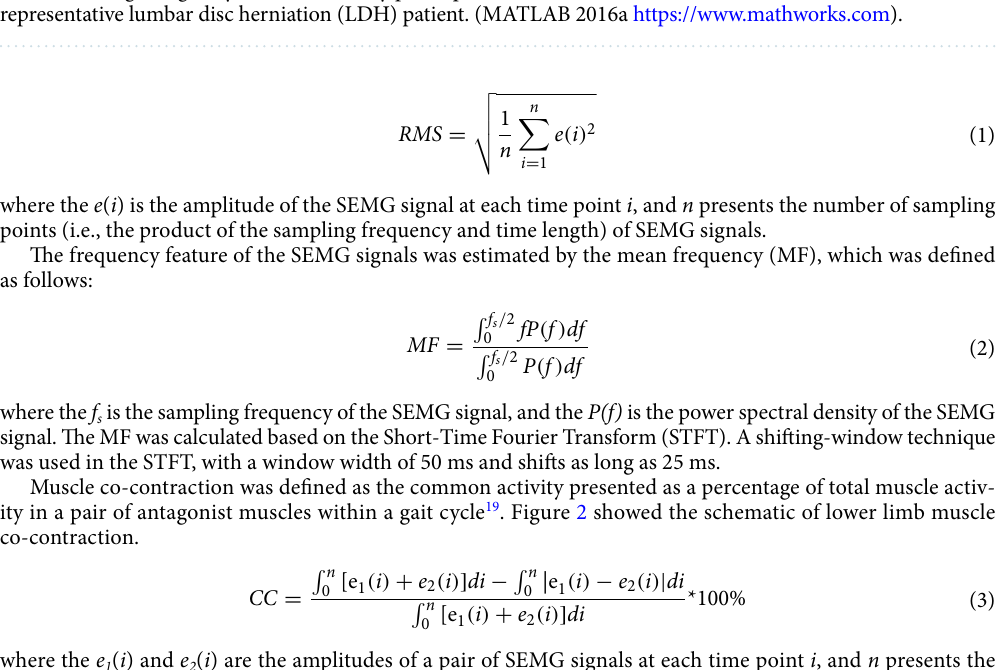
Figure 1. ( a ) One test participant with retro-reflective markers and surface electromyography (SEMG) electrodes in this experiment. ( b ) The full-wave rectified SEMG signals of the lateral gastrocnemius (LG) muscles during one gait cycle in one healthy participant as well as the affected and contralateral sides of a representative lumbar disc herniation (LDH) patient. (MATLAB 2016a https ://www.mathw